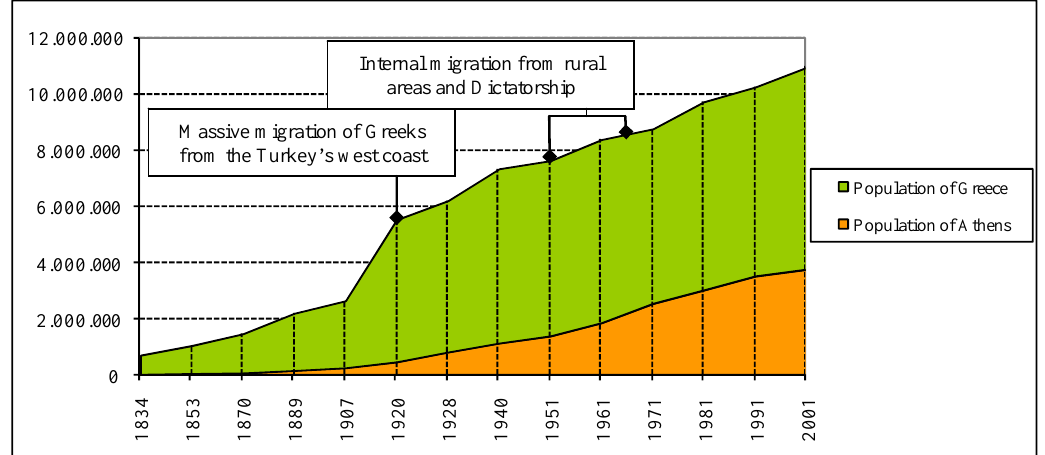
Figure 1. Population growth and historical landmarks from 1834 till 2001 in Athens Source: Leontidou, 2001, p.